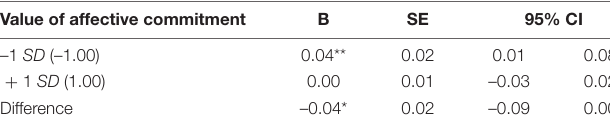
TABLE 4 | Conditional indirect effect as a function of affective commitment.